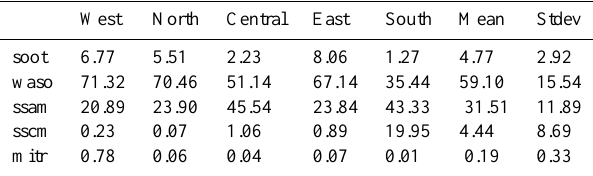
Table 3. Percentage % contribution of each aerosol component in the 5 BoB sub-regions according to OPAC model. The mean and standard deviations are also given. [waso: water soluble, ssam: sea- salt accumulation mode, sscm: sea-salt coarse mode, mitr: mineral